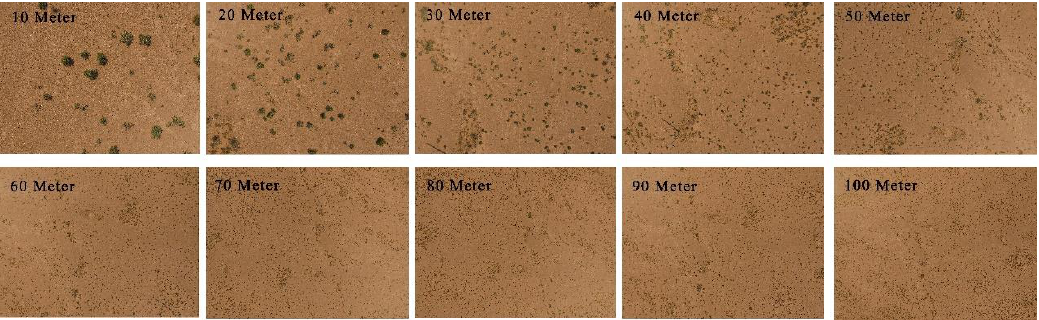
Figure 4. Photos taken by drones at different heights. Table 2. The size of the actual range of ground represented by the photos taken by the drone at di ff erent heights.